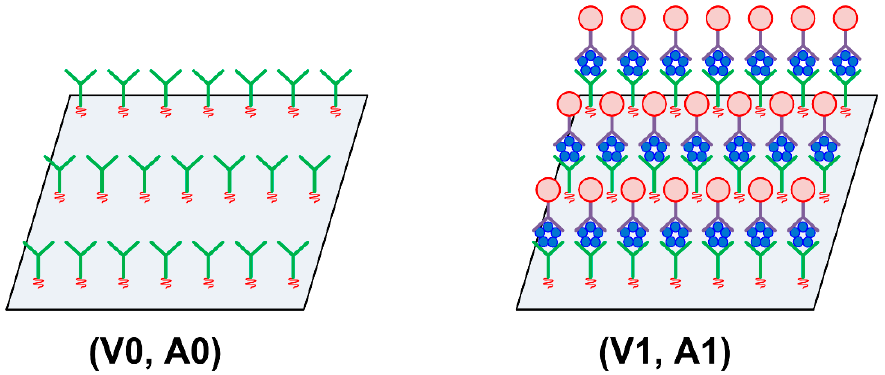
Figure 10. Surface images comparison of completely unreacted and reacted sensing areas.